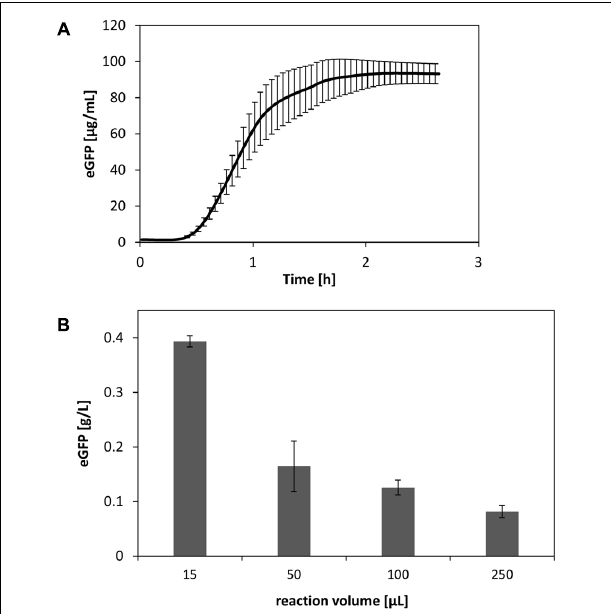
FIGURE 7 | (A) Optimized CFPS reaction of eGFP at a scale of 250 µ L. (B) Scale down of the CFPS reaction performed in reaction tubes. Error bars represent standard deviations of triplicate measurements.